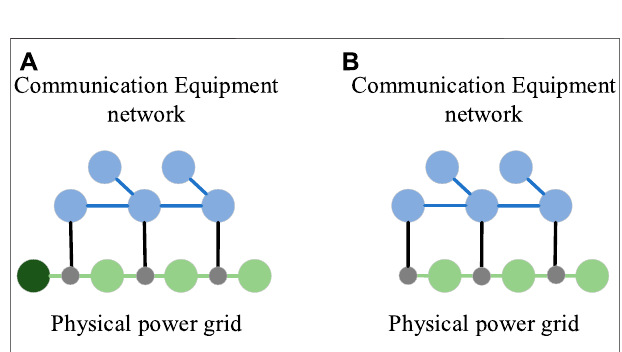
FIGURE 2 | Cascading process with virtual nodes added to cyber node failure (A,B) . (A) The fi rst step of the cascading failure. (B) The second step of the cascading